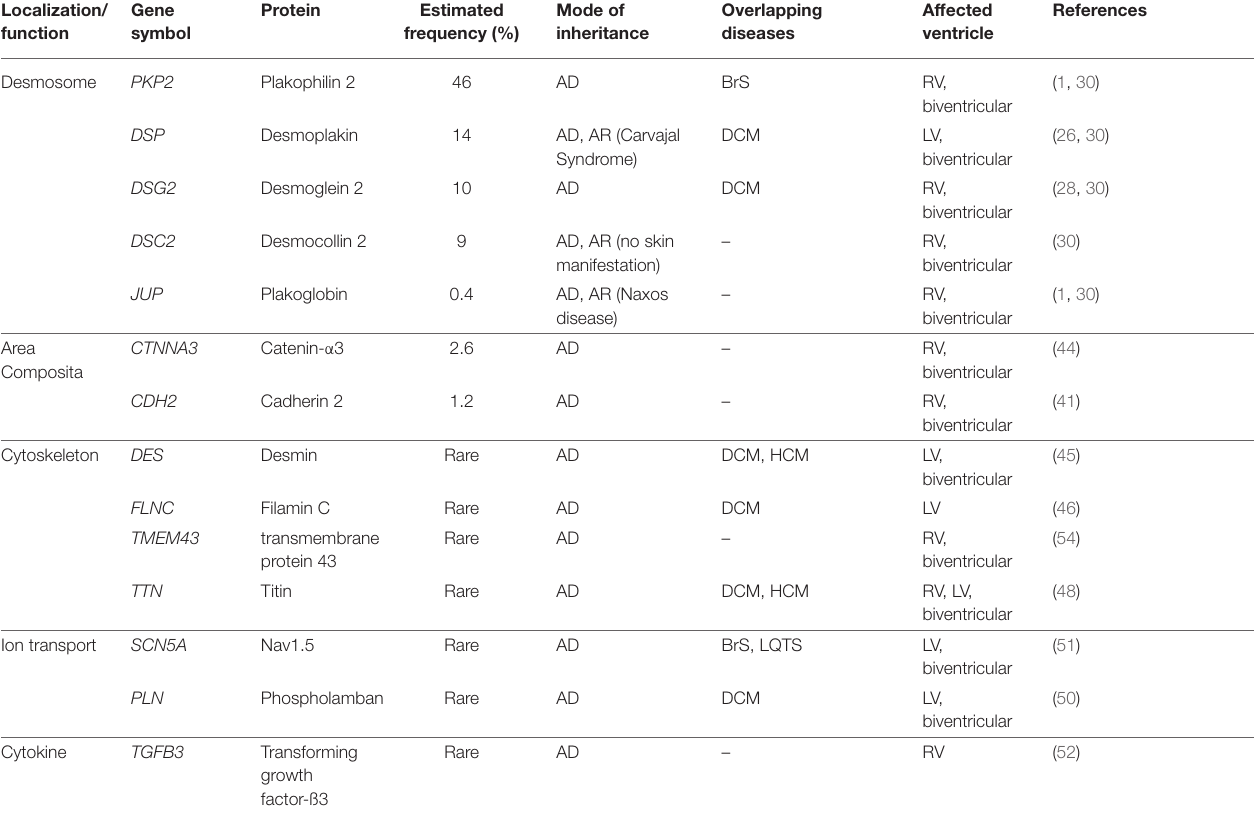
TABLE 1 | Genes associated with ACM.